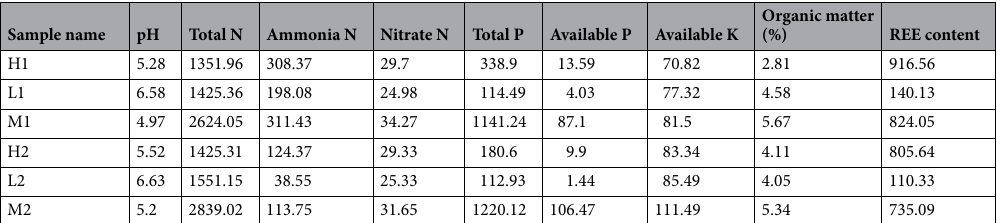
Table 4. Soil physical and chemical properties, nutrient elements and REE content (mg/kg). H1, M1 and L1 are rice and soil samples in tillering stage, H2, M2 and L2 are rice and soil samples in maturity stage, the same